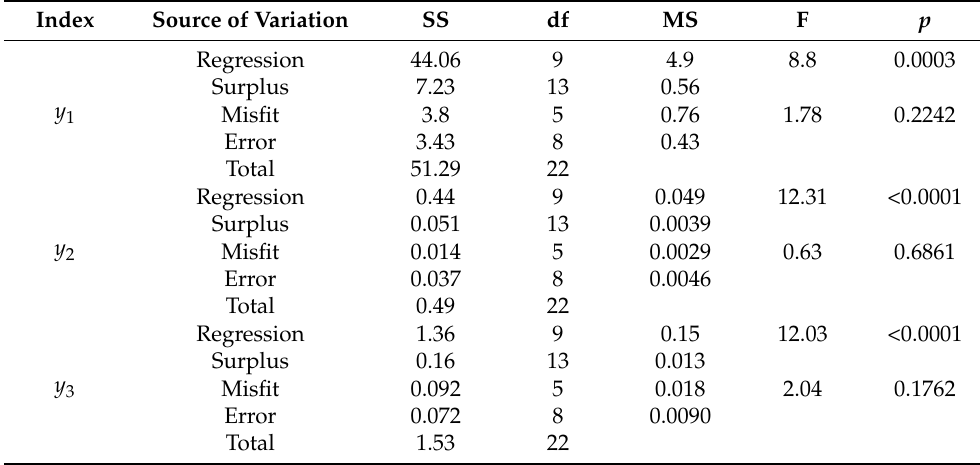
Table 4. Analysis of